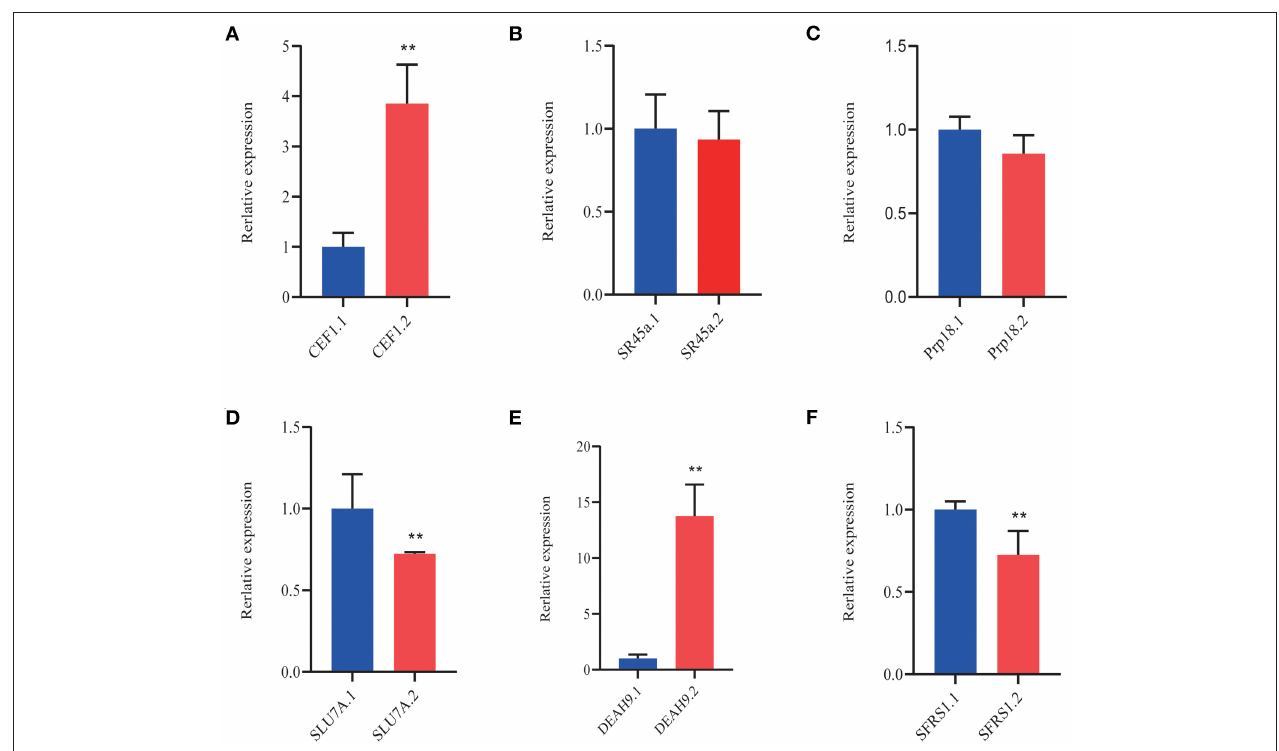
FIGURE 11 | QRT-PCR analysis of DAS isoforms of splicing-associated factors in P. ussuriensis compared with P. trichocarpa . (A) CEF1. (B) SR45a. (C) Prp18. (D) SLU7A. (E) DEAH9. (F)